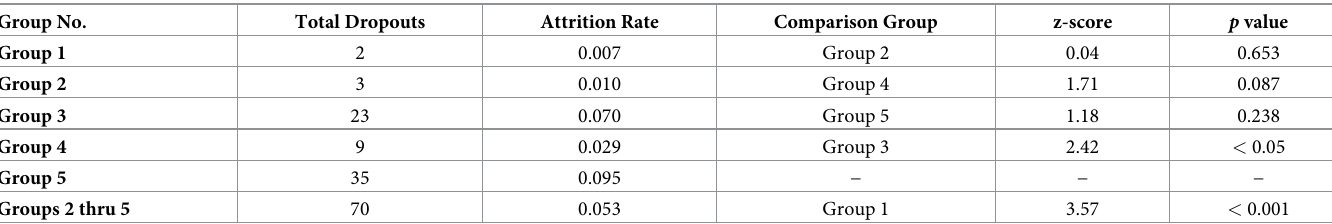
Table 1. Comparison of dropouts by group number. Group No. Total Dropouts Attrition Rate Comparison Group